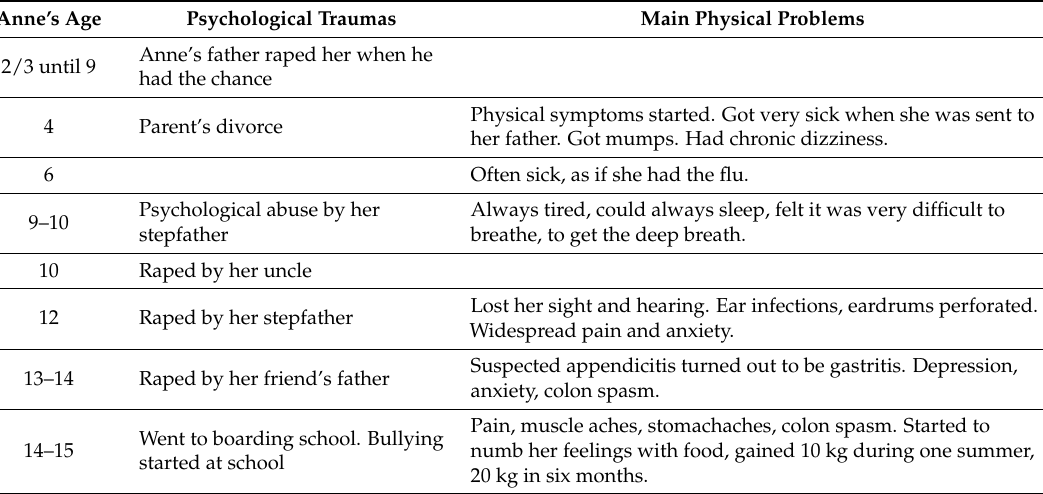
Table 4. An overview of Anne’s main psychological traumas and main physical health